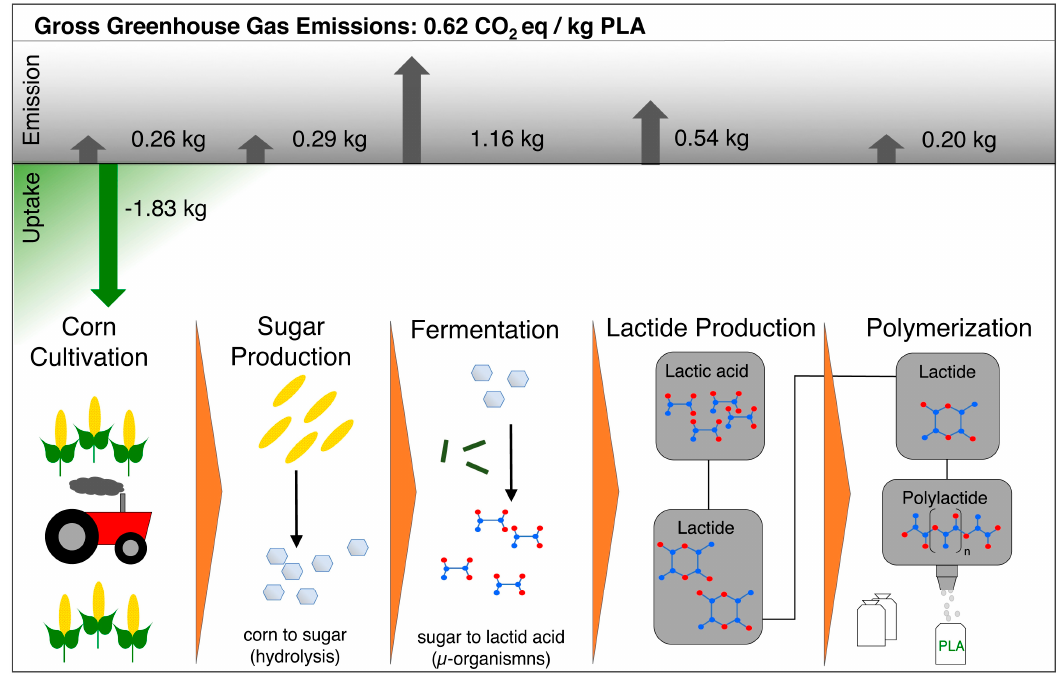
Figure 1. Steps of polylactide (PLA) production with greenhouse gas uptake and emissions for 1 kg of PLA (based on the data of Reference [4]).